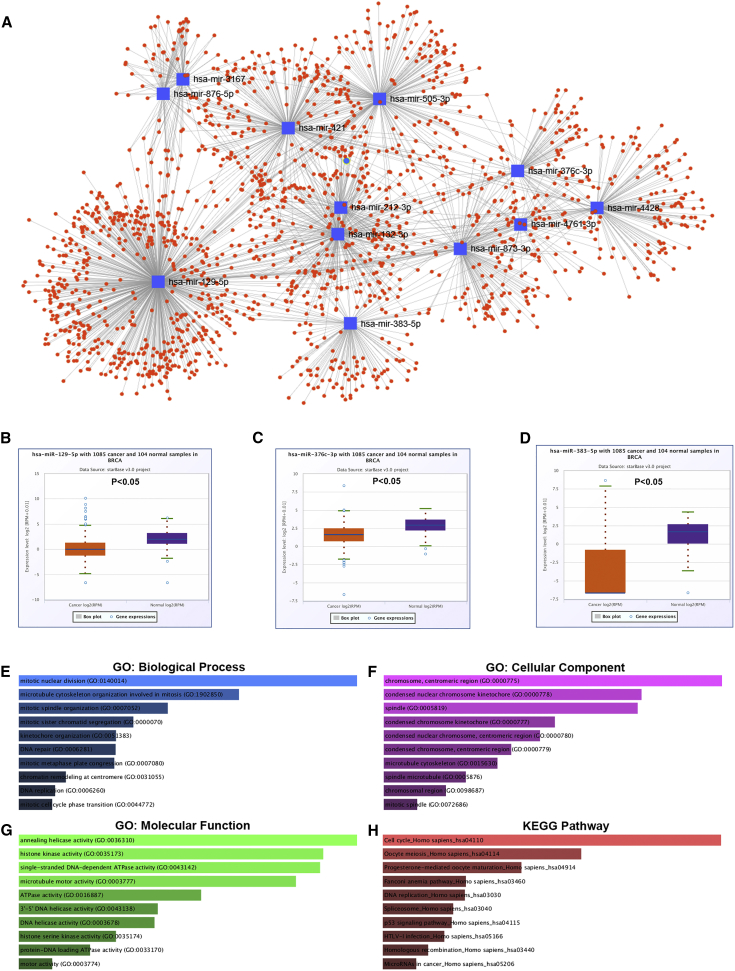
Construction of PTTG3P-miRNA-mRNA Network and Gene Ontology Functional Annotation and KEGG Pathway Enrichment Analysis for the Co-expressed Genes of PTTG3P(A) The potential pseudogene PTTG3P-miRNA-mRNA regulatory network; (B) expression of miR-129-5p in breast cancer tissues and normal controls determined by starBase v3.0; (C) expression of miR-376c-3p in breast cancer tissues and normal controls determined by starBase v3.0; (D) expression of miR-383-5p in breast cancer tissues and normal controls determined by starBase v3.0; (E) the top 10 enriched biological process (BP) items for the co-expressed genes of PTTG3P; (F) the top 10 enriched cellular component (CC) items for the co-expressed genes of PTTG3P; (G) the top 10 enriched molecular function (MF) items for the co-expressed genes of PTTG3P; and (H) the top 10 enriched KEGG pathway items for the co-expressed genes of PTTG3P.